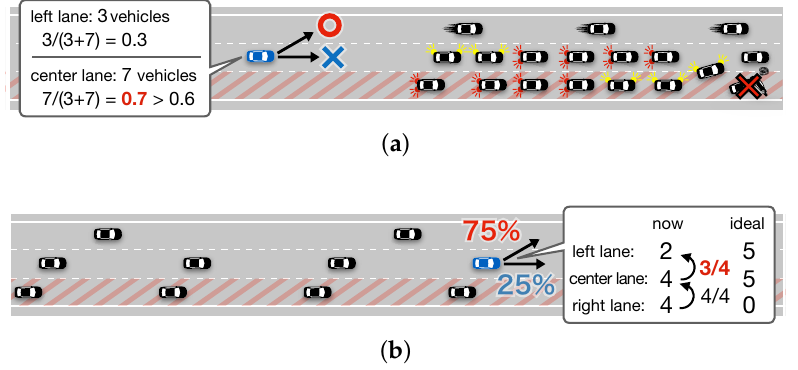
Figure 4. Adaptive lane change. ( a ) Strategy 1: Avoiding congested lanes. ( b ) Strategy 2: Adjusting the balance among